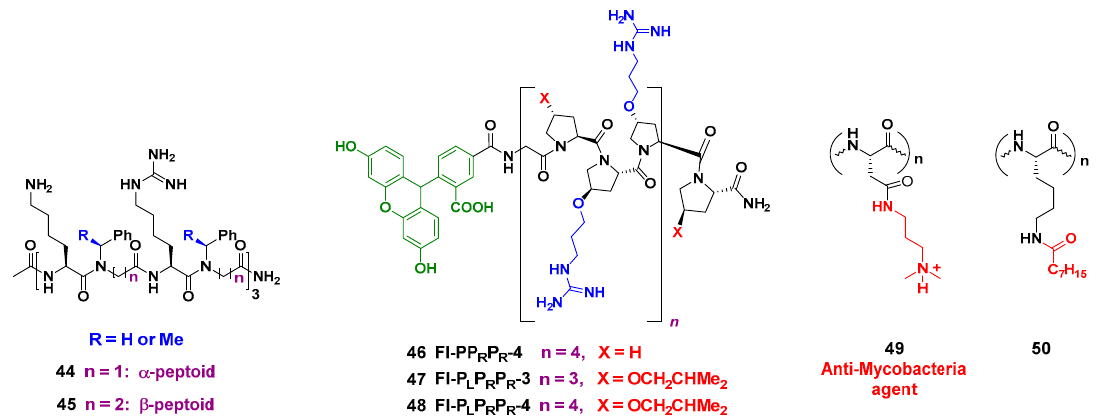
Figure 7. AMP analogs: ( Left ) α - and β -peptoids 44 and 45 ; ( Center ) substituted PrAMPs 46 – 48 ; ( Right ) introduction of cationic chains in analogues 49 and capped-termini derivatives 50 .